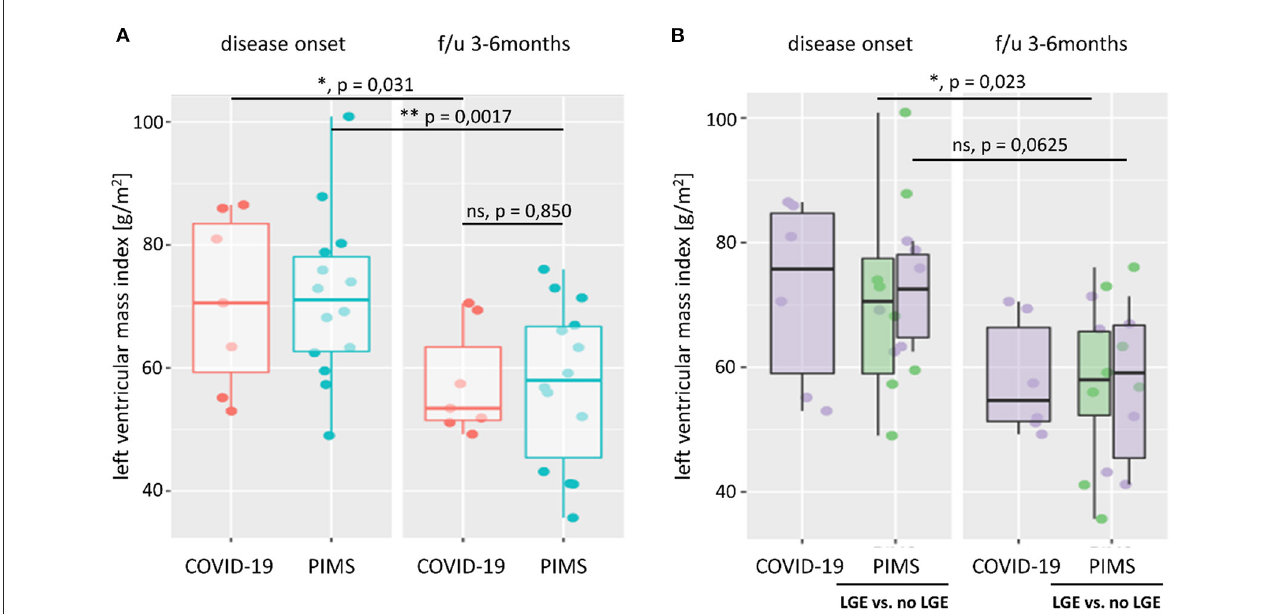
FIGURE3 Left ventricular mass index. Left ventricular mass index (LVMI) was calculated from body surface area, and left ventricular mass was estimated using the Devereux equation. In (A) , we compare LVMI of patients with severe acute COVID-19 (red) or pediatric inflammatory multiorgan syndrome (PIMS, blue) at the time of disease onset and last follow-up (f/u) visit 3–6 months later. At both time points, there was no significant difference in LVMI between the two diagnoses ( p = 0.971 at disease onset; p = 0.850 at f/u). However, both groups saw a significant reduction in LV mass (not shown) and LVMI at f/u. As shown in (B) , there was also no significant difference in LVMI between patients with PIMS with or without (green) late gadolinium enhancement (LGE) in cardiac MRI at the time of disease onset ( p = 0.660) or f/u ( p = 1). The difference n LVMI between non-LGE PIMS was more pronounced ( p = 0.023) than in PIMS with LGE ( p = 0.0625). See also Supplementary Figure 3 for LV z scores and connected dot